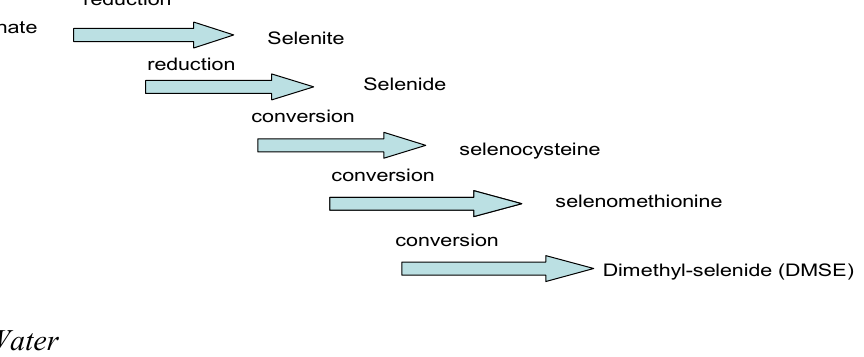
Se] in not accumulating selenium plants 2